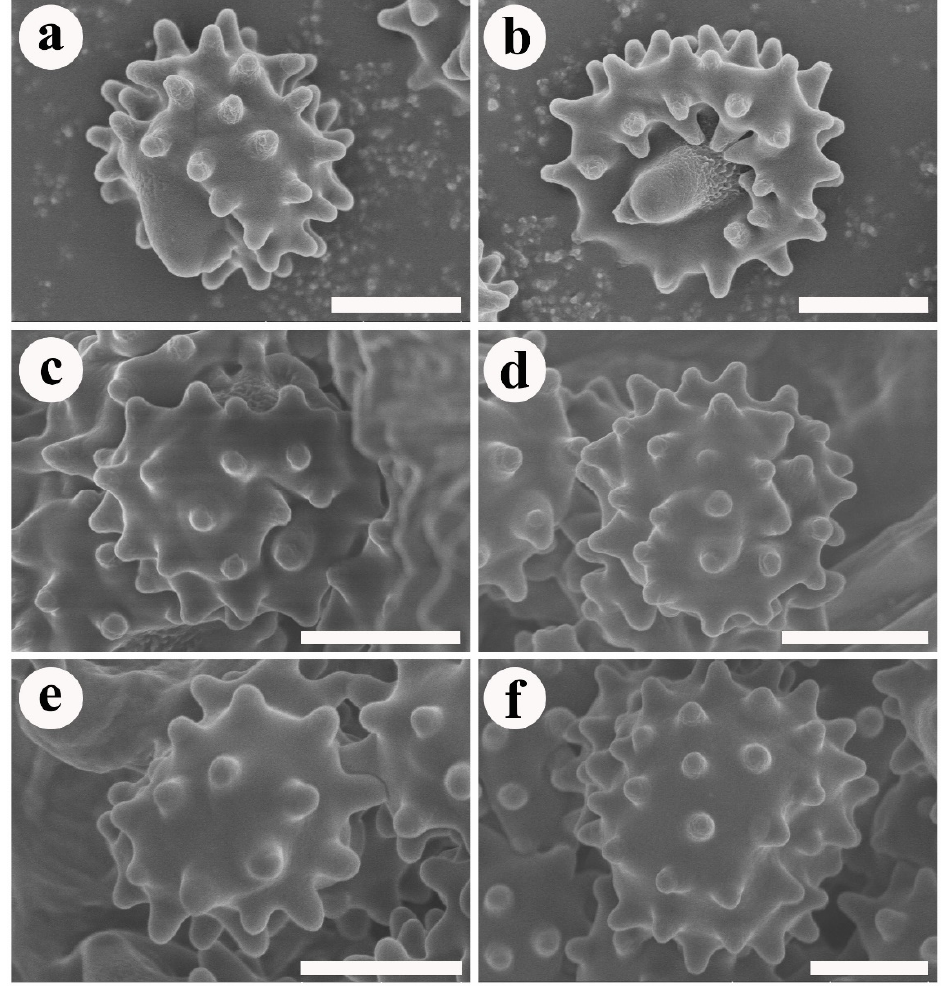
Figure 4. SEM of basidiospores of Phellodon species. ( a , b ) P. crassipileatus , ( c , d ) P. griseofuscus , and ( e , f ). P. perchocolatus . Scale bars: 1.5 µm. Phellodon griseofuscus B.K. Cui and C.G. Song, sp. nov., Figure 3b, Figure 4c,d, and Figure 6. MycoBank: